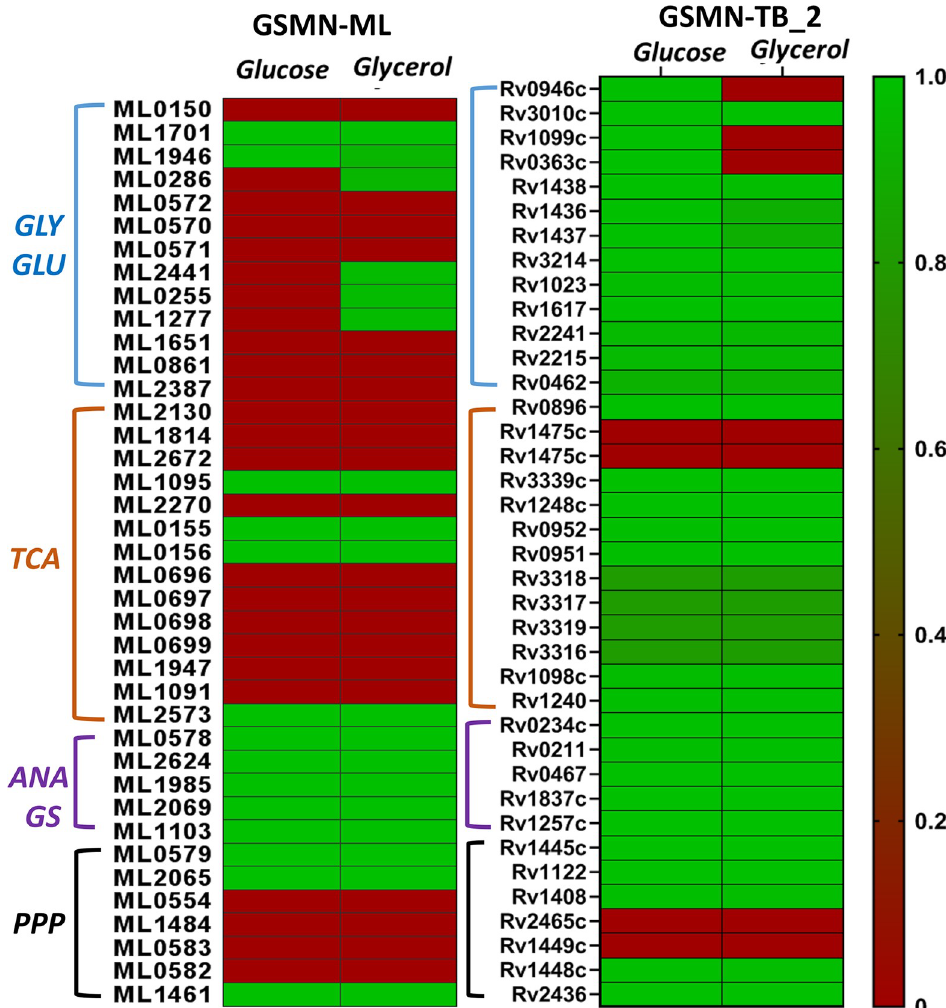
Fig 5. Gene essentiality analysis of GSMN-ML and GSMN-TB_2 utilizing glucose and glycerol as carbon sources. Heat map showing the gene essentiality (GS) predictions of central carbon metabolic genes of the two models using glucose and glycerol as the sole carbon sources (see Supplementary S7 and S8 Files for details and the calculated values). Simulations were performed in SurreyFBA platform to calculate GS which is the ratio of growth rate of the knockout to that of the wild type. A gene was considered essential if the GS ratio < 0.01 and the GS ratio of the essential genes were 0. Essentiality is indicated by single colour gradient with the maximum GS ratio of 1 (green) and minimum GS ratio